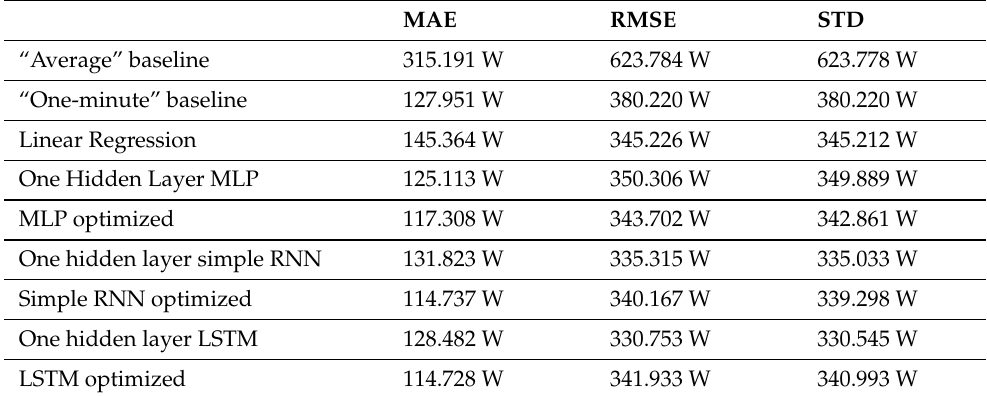
Table 2. Mean Absolute Error (MAE), Rooted Mean Squared Error (RMSE), and Standard Deviation (STD) measured (Watts) in the Training, Validation, and Test phase of each model. MAE